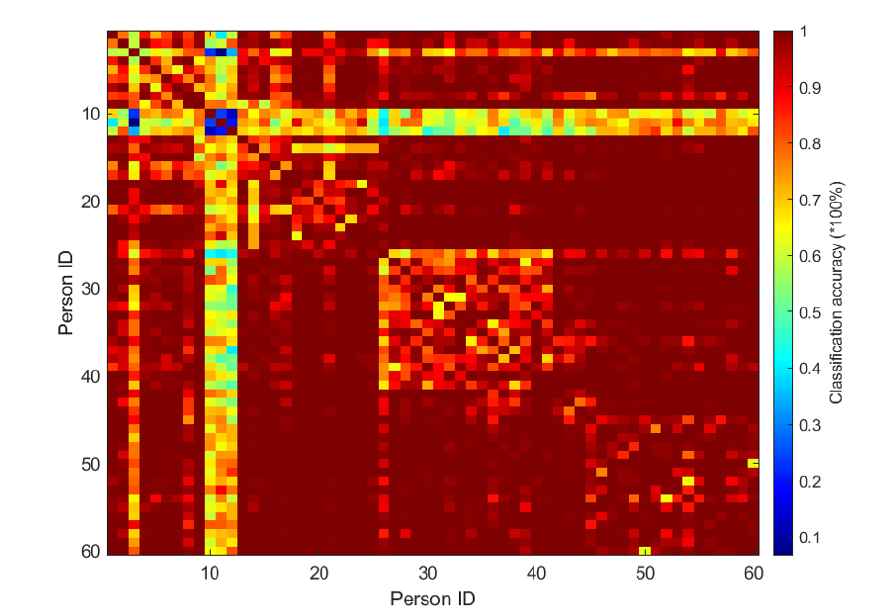
Figure 18. Confusion matrix of one versus one classification with the trained model.